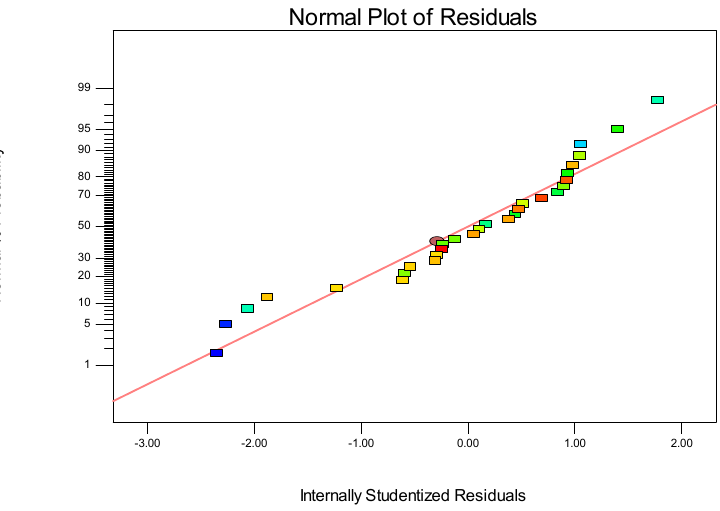
Figure 13. Predicted versus experimental values plot for EV removal.